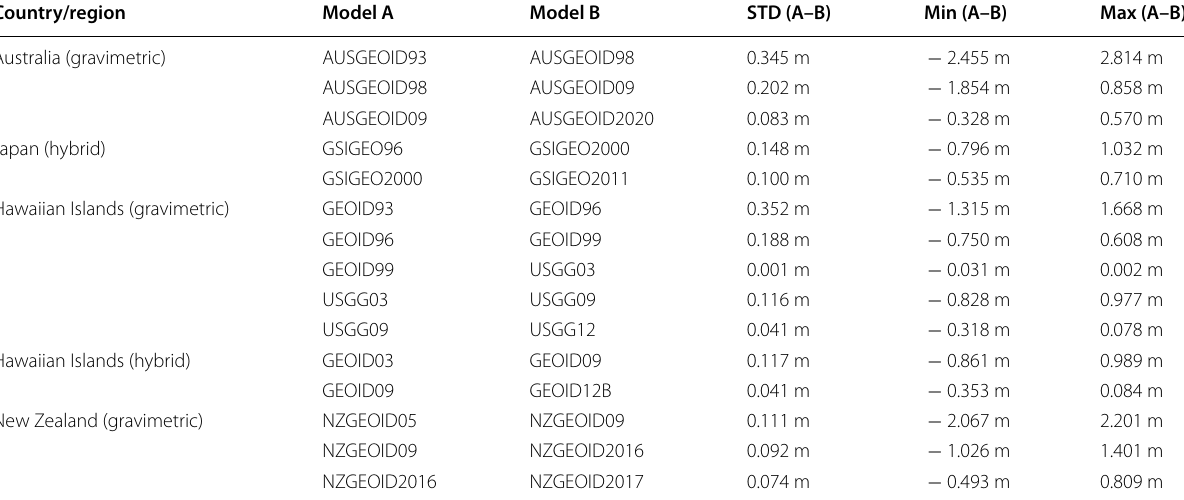
Table 3 Statistics on the residuals of national geoid series comparisons, for all the series stored in the ISG geoid repository